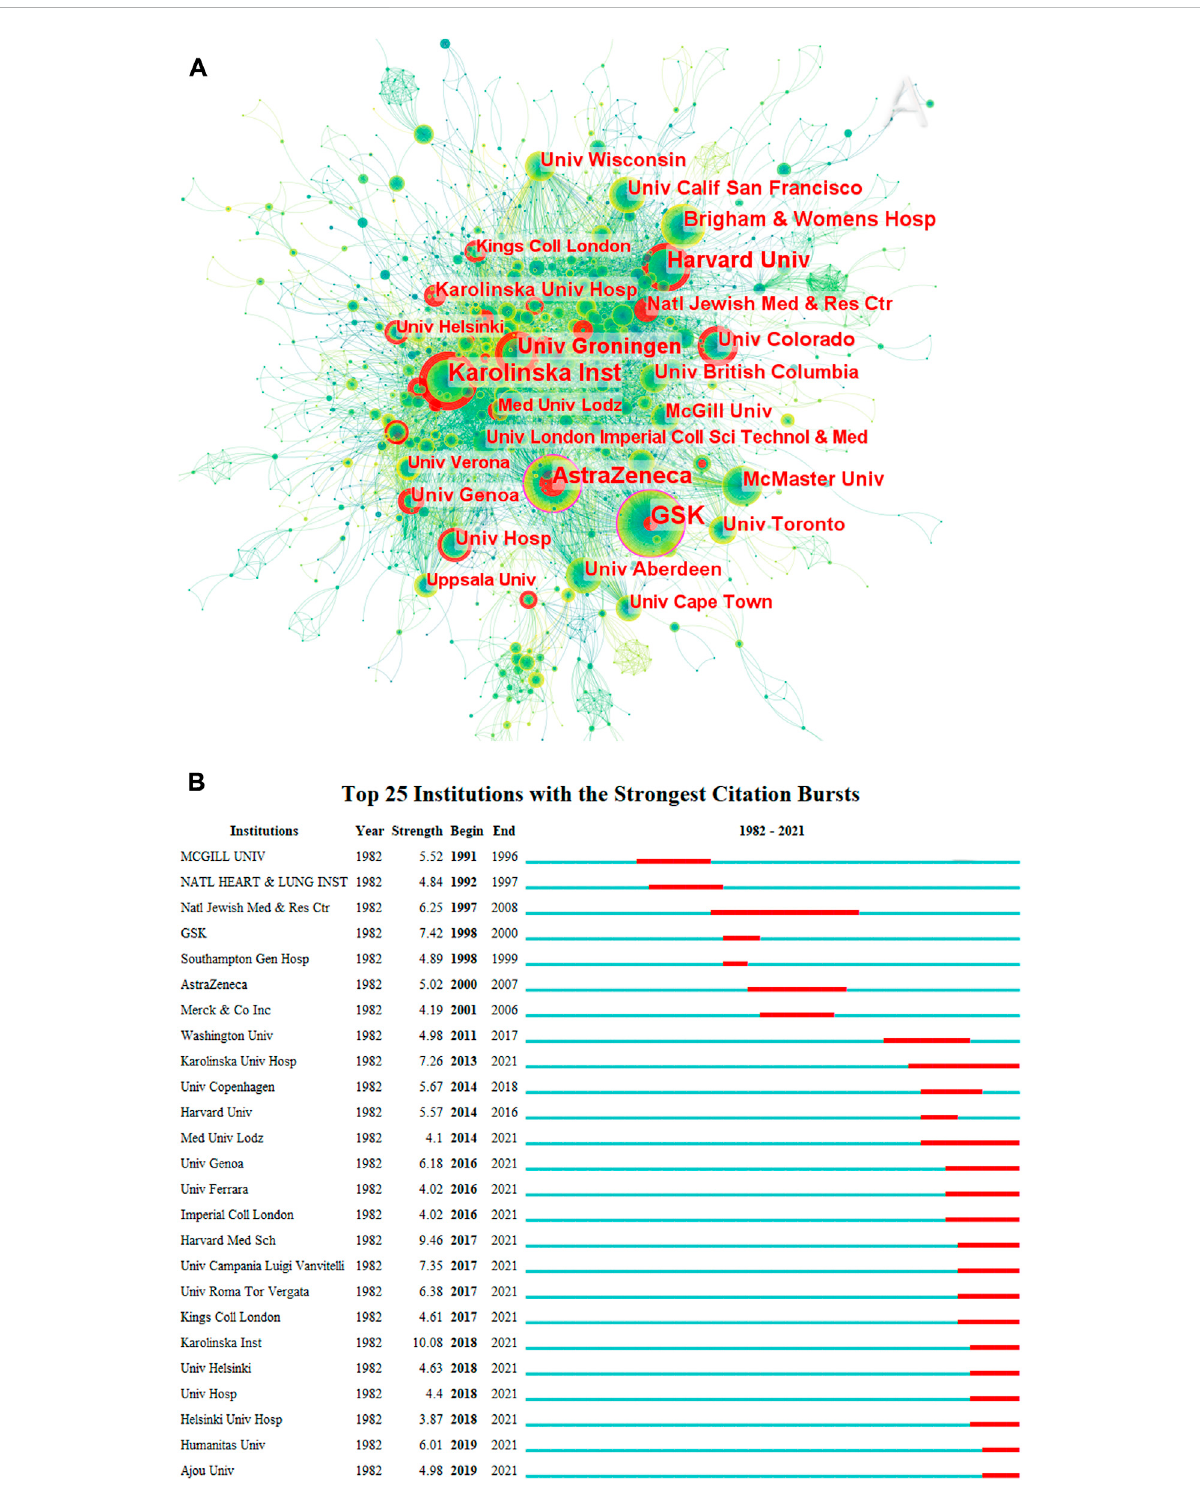
FIGURE 2 Co-occurrence map of institutions (A) and top 25 institutions with strongest citation bursts in asthma drug-related studies (B) (CiteSpace 6.1. R3).